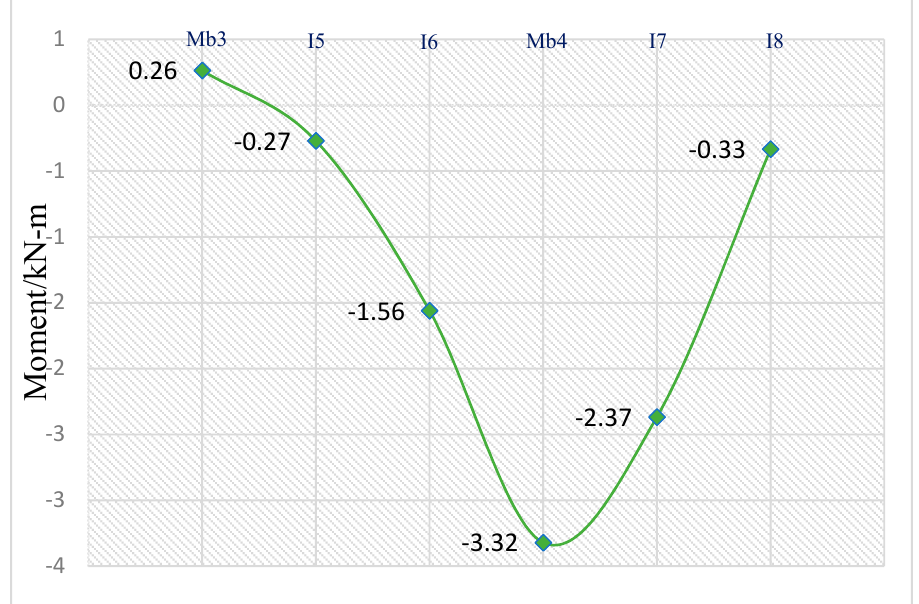
Figure 11. Moment distribution over support